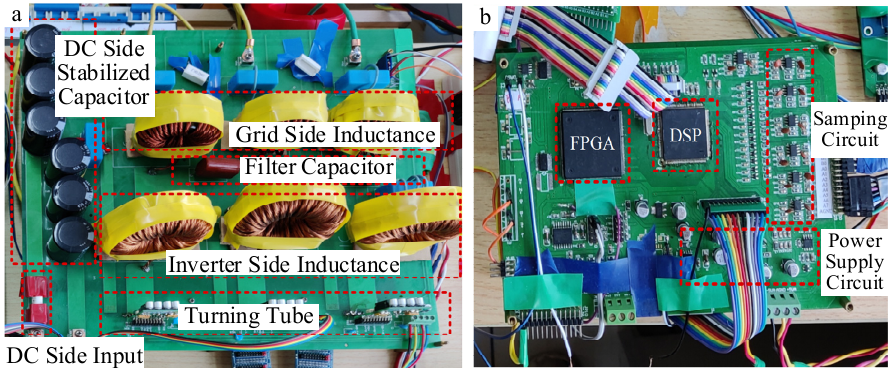
Figure 17. Experimental platform circuit. ( a ) The main circuit; ( b ) The control circuit.